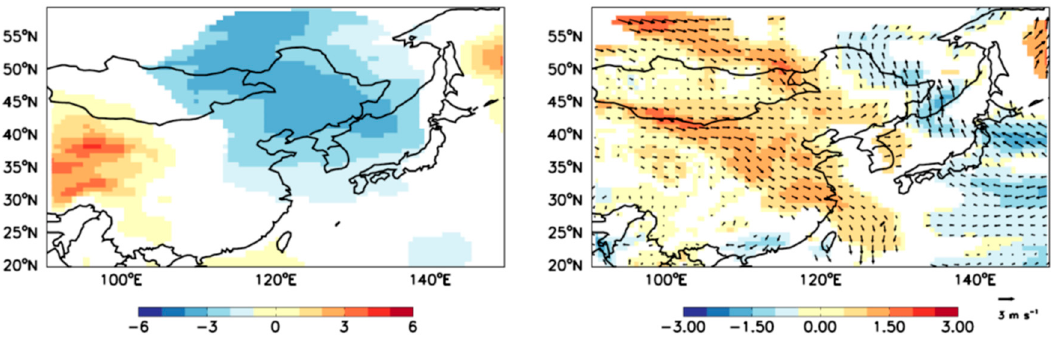
Figure 6. Regressed ( a ) sea level pressure (left panel) and ( b ) wind (shading: wind speed; vector: wind; right panel) at 850 hPa against the CTP for 2002–2017. The shading and vector only are plotted at the 90% confidence level. Units are hPa and m s − 1 , respectively.